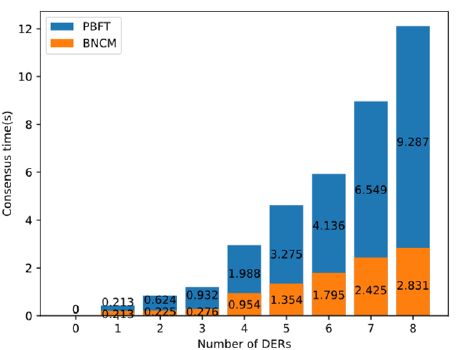
Figure 15. The relationship between DERs number and collaboration time under different collaboration mechanisms.